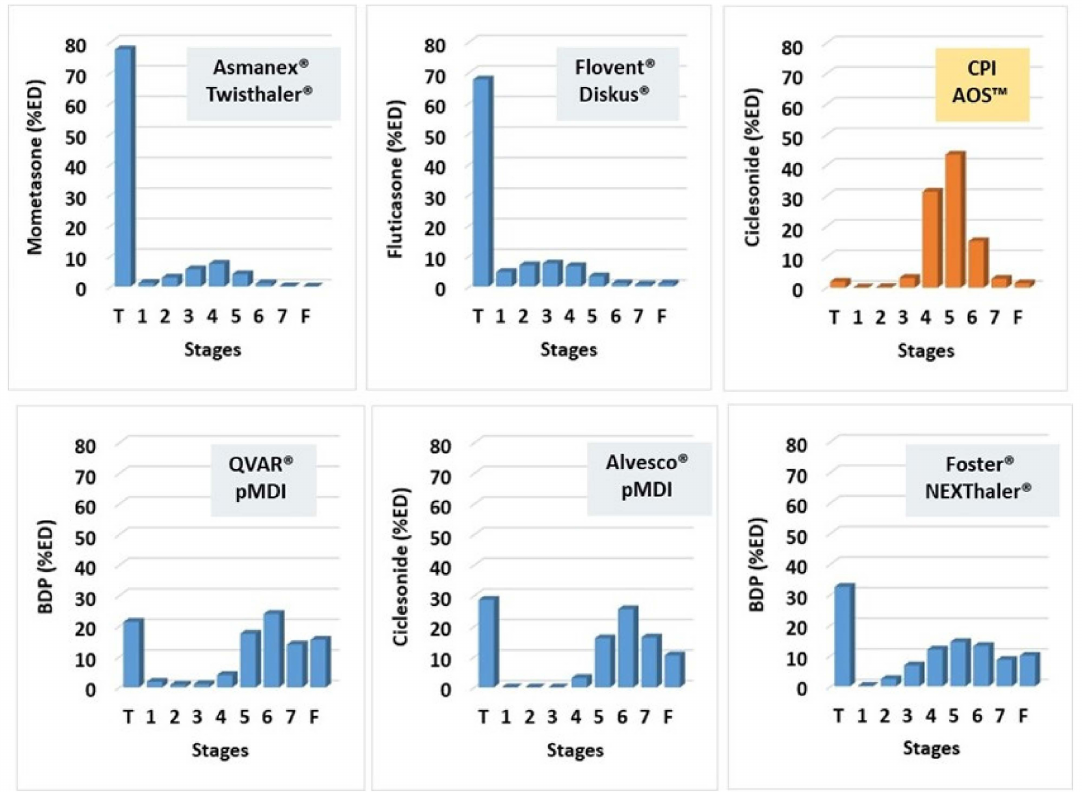
Figure 9. Aerodynamic particle size distributions of inhaled corticosteroid formulations